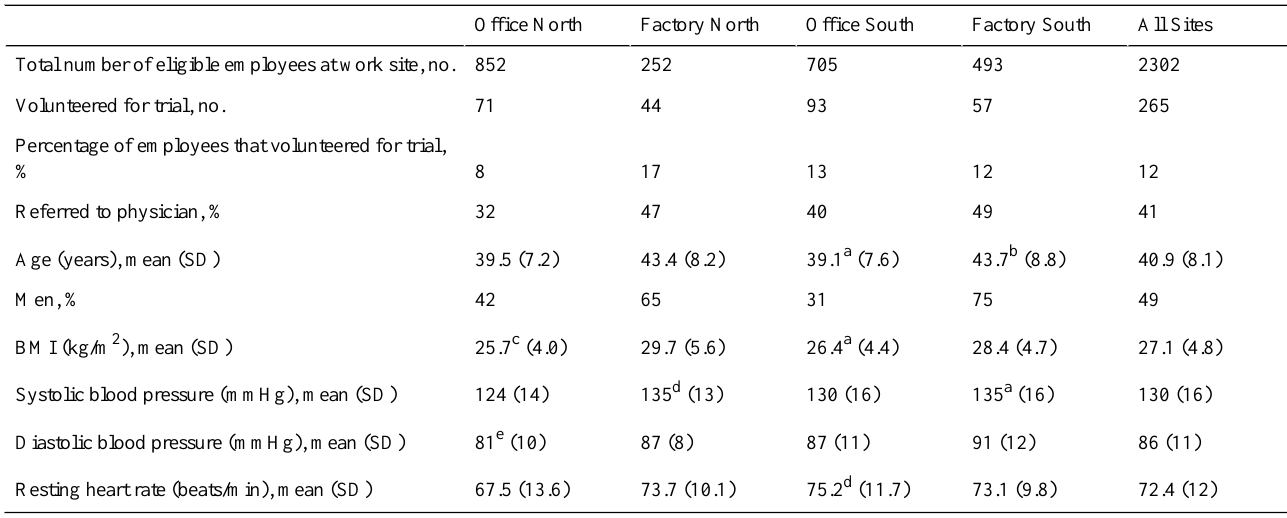
All SitesFactory SouthOffice SouthFactory NorthOffice North